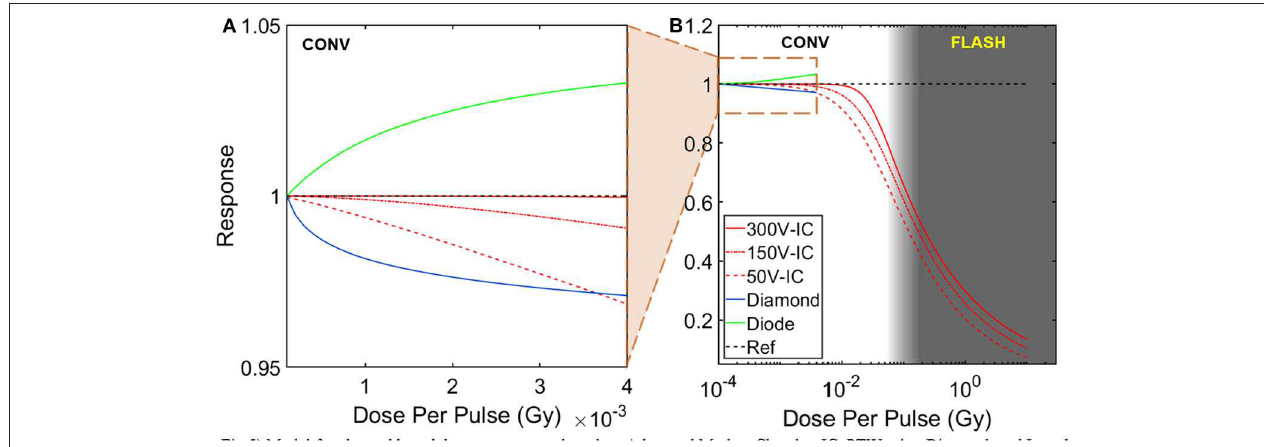
FIGURE 5 | Model for charged based detector response based on Advanced Markus Chamber IC, PTW microDiamond, and Isorad Gold (n-type) diode detectors. Dose per pulse dependency of detector response are shown for (A) conventional beams and (B) FLASH beams. Advanced Markus Chamber IC response (charge collection efficiency) was calculated for three different bias voltages and the only charge-based detector to be tested in FLASH dose rates [48]. Model for diamond detector response (charge collection efficiency) and diode detector response (sensitivity) were only tested at conventional dose rates [49,